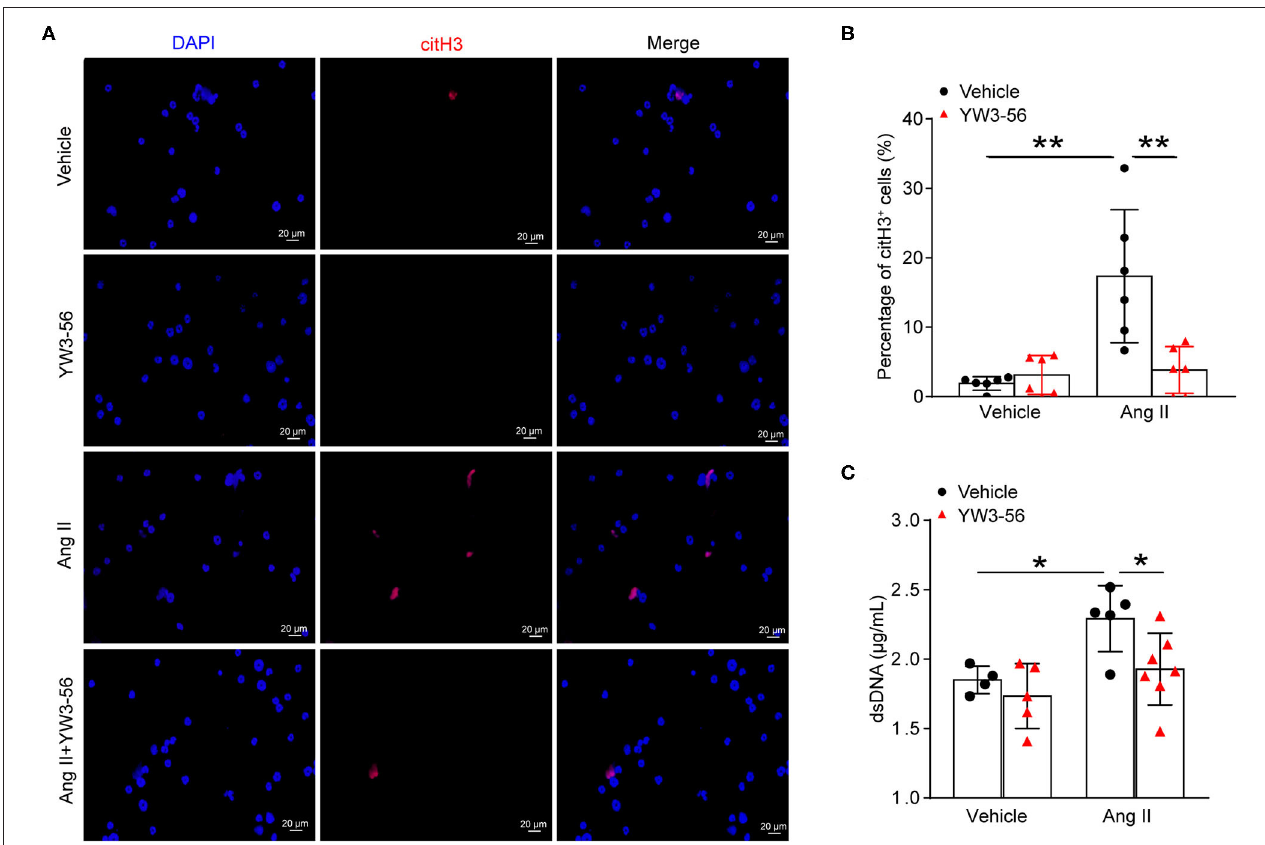
FIGURE 3 | PAD4 inhibitor YW3-56 suppressed Ang II-induced NET formation in vitro . Bone marrow-derived neutrophils from ApoE − / − mice were treated with vehicle or 5 µ M Ang II for 4h in the presence of vehicle or YW3-56. (A) Immunofluorescence analysis for citH3 (red). Nuclei were stained with DAPI. (B) Measurement of the percentage of citH3-positive cells. n = 6 per group, ** p < 0.01. (C) Measurement of dsDNA in vehicle or Ang II-stimulated neutrophils with or without YW3-56 treatment. n = 4/vehicle group, n = 5/YW3-56 group, n = 5/Ang II group, n = 7/Ang II + YW3-56 group, * p < 0.05. Statistical significance was determined